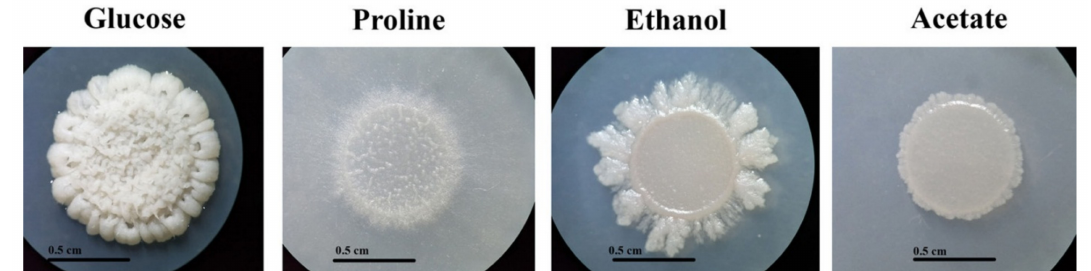
Figure 2. Yeast-like colony morphology of T. marne ff ei on gluconeogenic carbon sources. The 10 8 conidia / 5 µ L of T. marne ff ei were spotted onto carbon-free medium containing 1.0% glucose, 50 mM proline, 0.5% ethanol, or 50 mM sodium acetate as the sole carbon source and incubated at 37 ◦ C for 10 days. The yeast-like colony appearances on the gluconeogenic media were di ff erent from the yeast-like colony appearance on the glucose medium (Figure 2). The colony morphology revealed a white, raised yeast-like colony on the glucose medium. In contrast, the yeast-like colonies on the gluconeogenic carbon-containing media presented as flat and white with various shapes. The conidia could not germinate or elongate in the gluconeogenic carbon sources at 37 ◦ C.